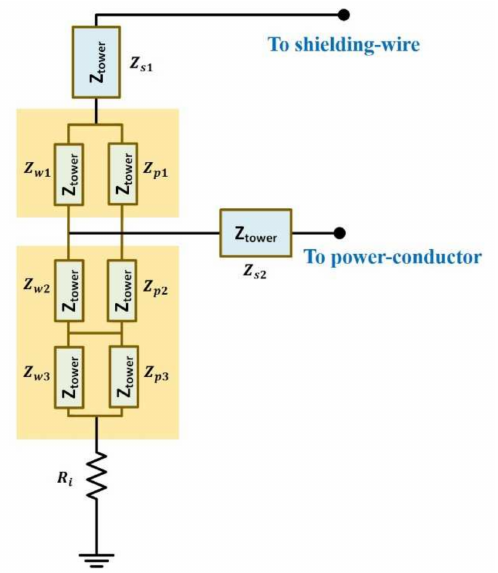
Figure 5. Surge impedance model of DC tower simulated in ATP